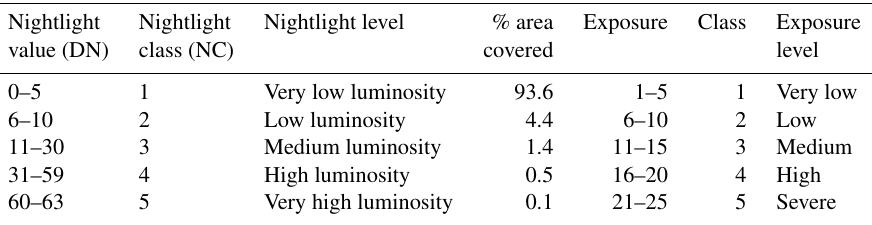
Table 3. Classes of nightlight luminosity in Canada from 1 to 5. The exposure classes were selected based on the product of nightlight and land-use